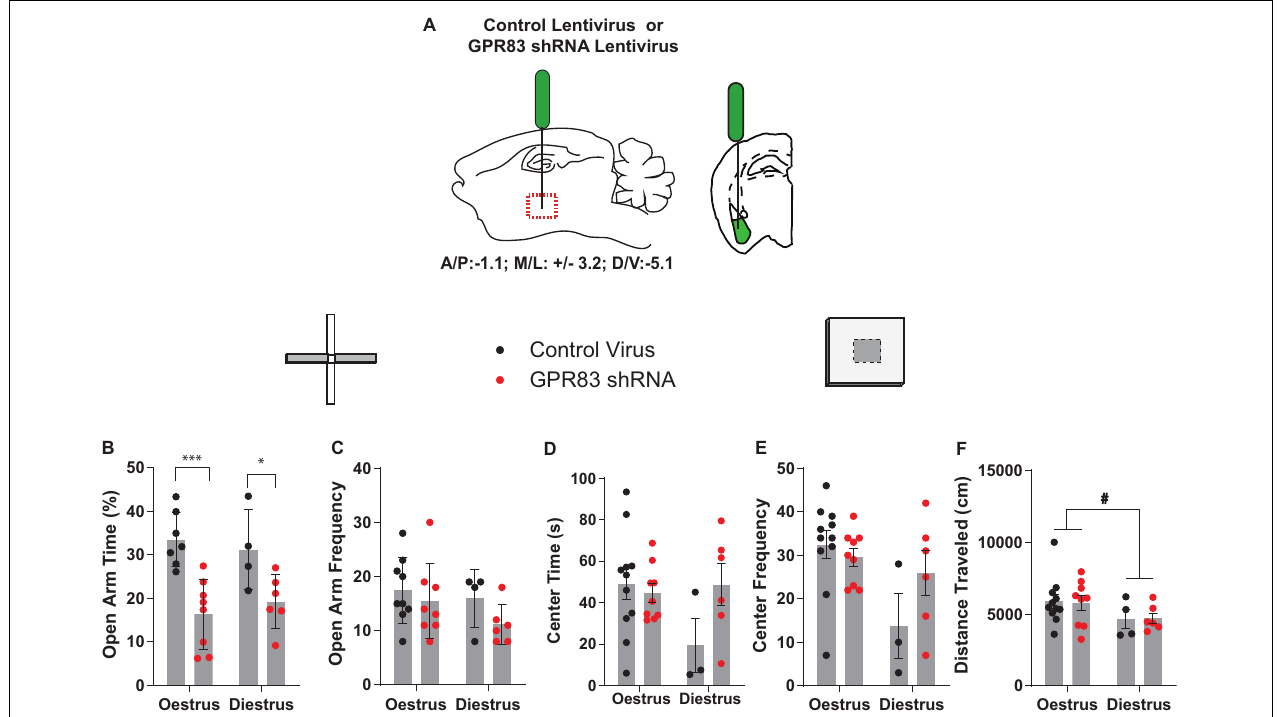
FIGURE 6 | Analysis of estrus cycle-dependent differences in anxiety-related behaviors following GPR83 knockdown in the BLA. (A) Schematic of injection of control or GPR83 shRNA lentivirus into the BLA. Analysis of estrus cycle-dependent differences following GPR83 knockdown in the BLA, on the elevated plus maze and open field assays, measuring open arm time (B) , frequency to enter the open arm (C), center time (D) , frequency to enter the center (E) , and distance traveled (F) . Data are represented as mean ± SEM and analyzed using two-way ANOVA following Tukey’s post hoc test, % = open arm time/(open arm + closed arm time), * p < 0.05, *** p < 0.001, unpaired t -test, # p < 0.05; n = 3–11 per